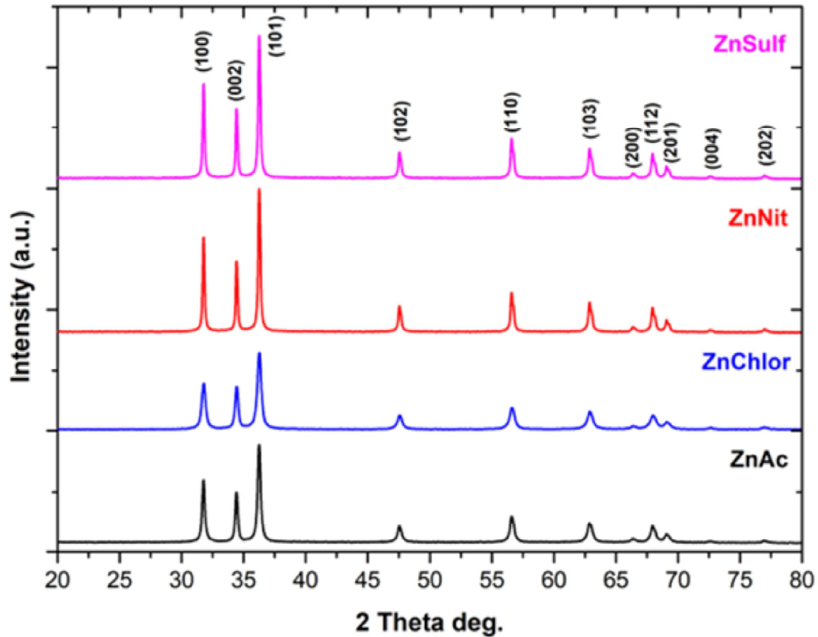
Figure 2. XRD diffractograms of ZnO nanoparticles, synthesized using as precursor zinc acetate dehydrate (in black) (ZnAc), zinc chloride (in blue) (ZnChlor), zinc nitrate hexahydrate (in red) (ZnNit), and zinc sulphate heptahydrate (in purple) (ZnSulf). Table 2. d-spacing calculations for ZnAc The formed peaks at 2 θ : 31.74°, 34.42°, 36.26°, 47.57°, 56.63°, 62.89°, 66.43°, 67.95°, 69.07°, 72.69°, and 76.86° correspond to the (100), (002), (101), (102), (110), (103), (200), (112), (201), (202), and (004) (Miller indices) planes, respectively. Particularly, crystal lat-